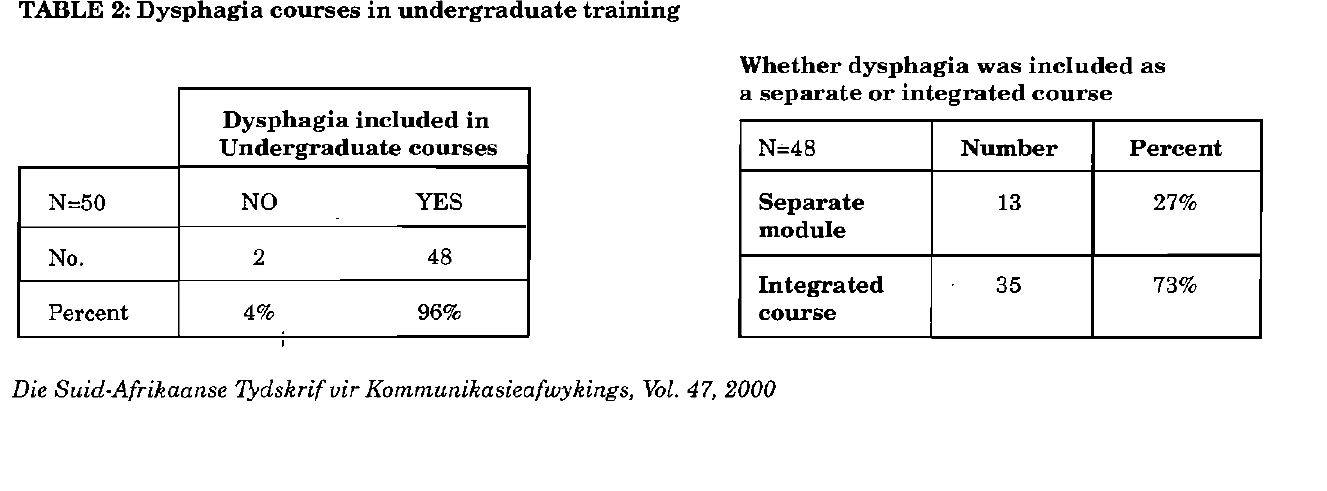
TABLE 2: Dysphagia courses in undergraduate training